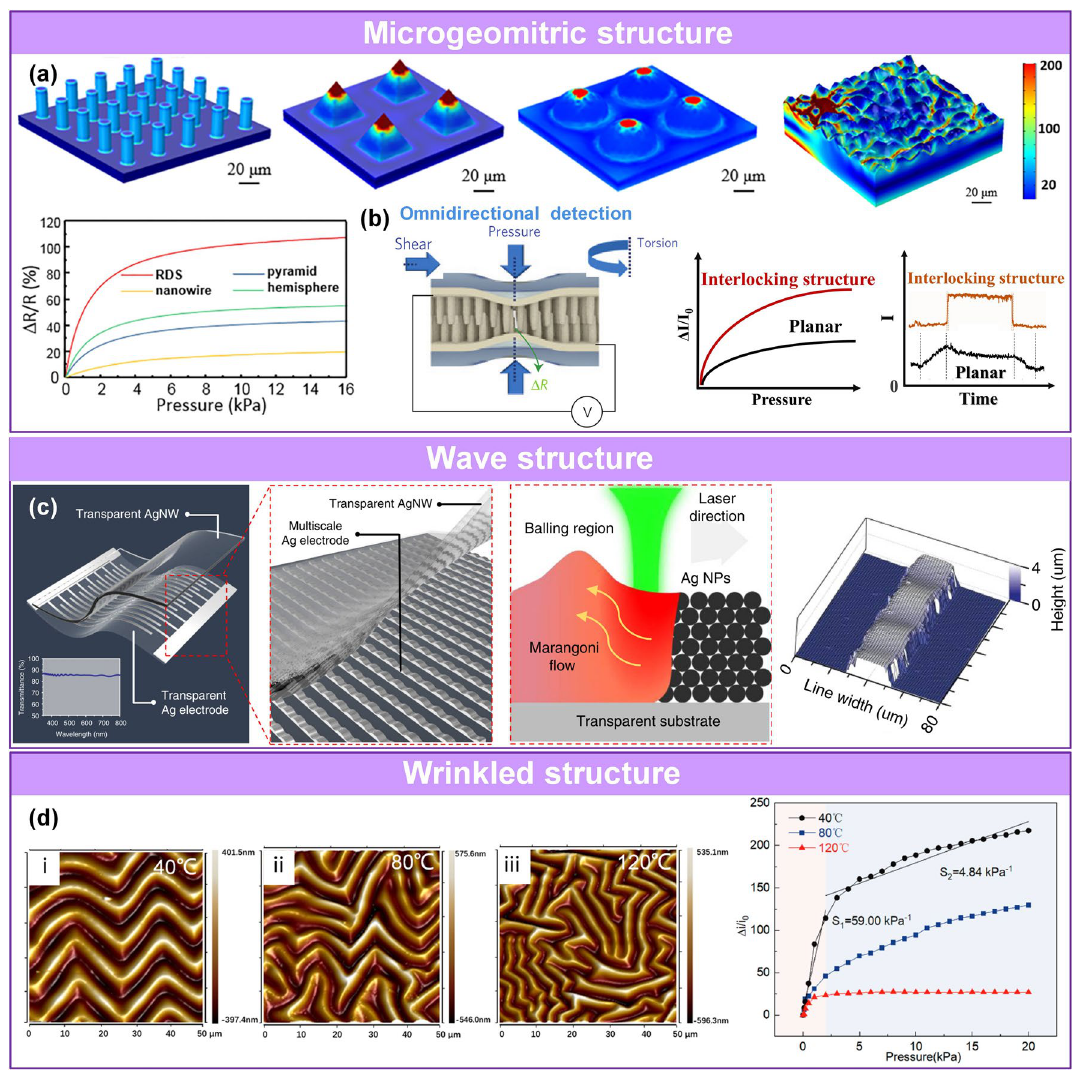
Fig. 4 Sensing materials with microrough structures. a Sensing materials with microgeometric structures [102]. Copyright (2018) American Chemical Society. b Advantages of interlocking structures [25, 140]. Copyright (2015) Wiley–VCH and (2012) Springer Nature. c Wave